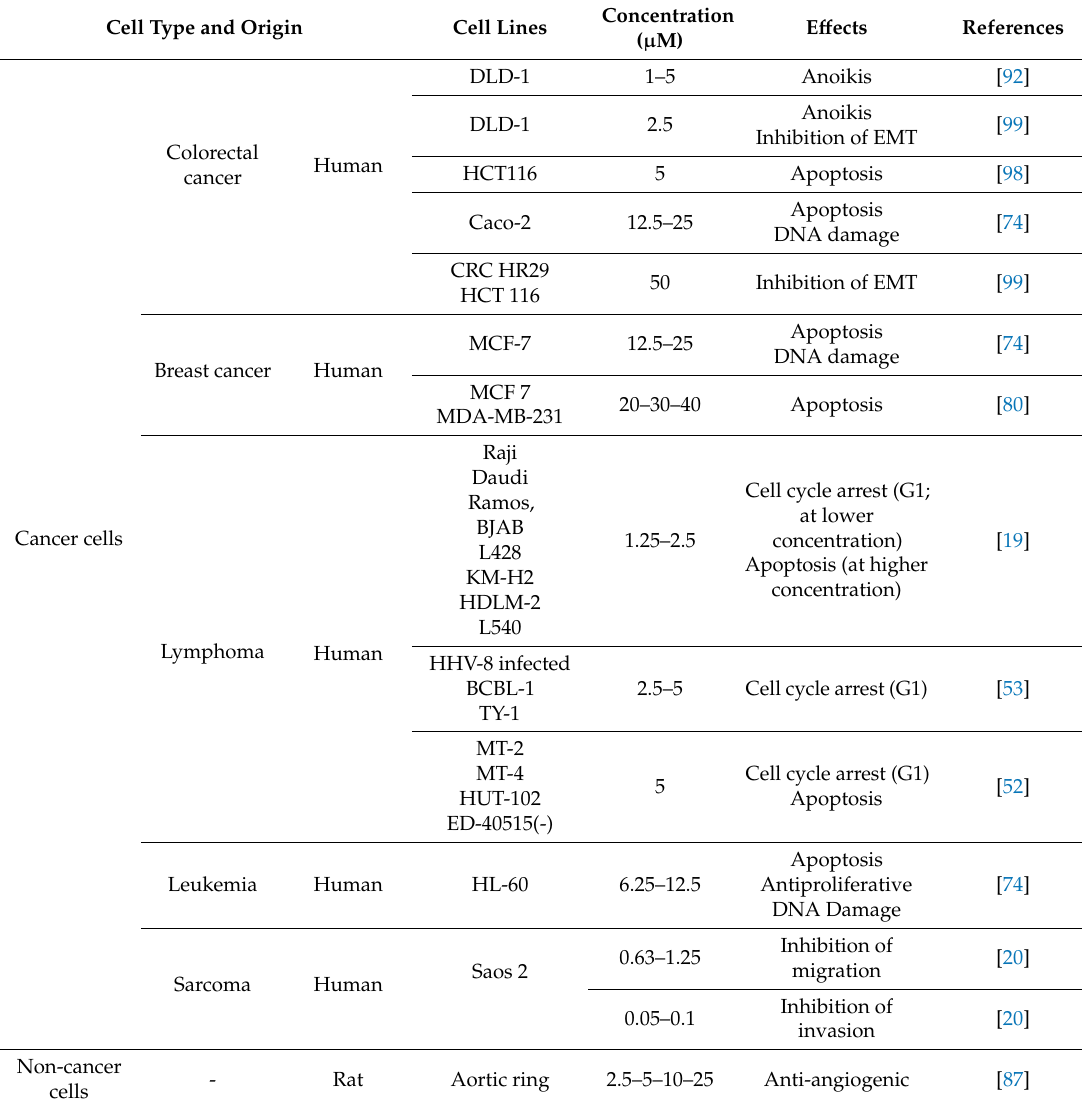
Table 4. In vitro e ff ects of fucoxanthinol on cancer and non-cancer